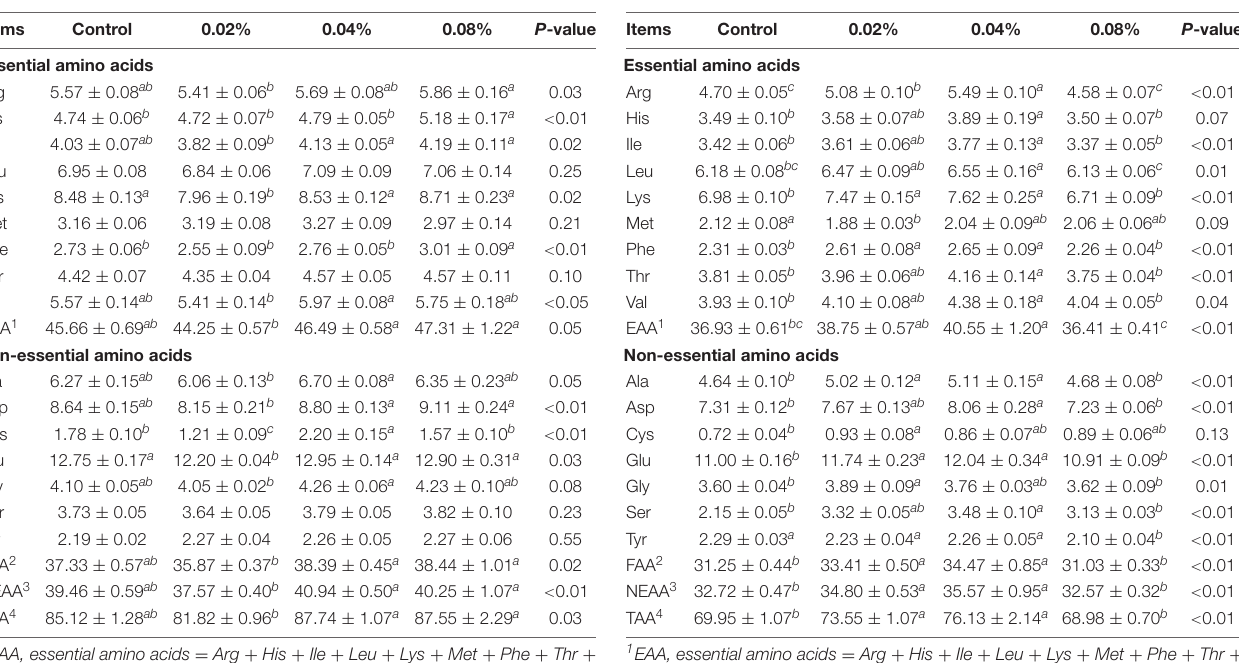
TABLE 6 | Effects of different levels of dietary CGA supplementation on the content of hydrolyzed amino acids in LD muscle of the finishing pigs ( µ g/100 mg).